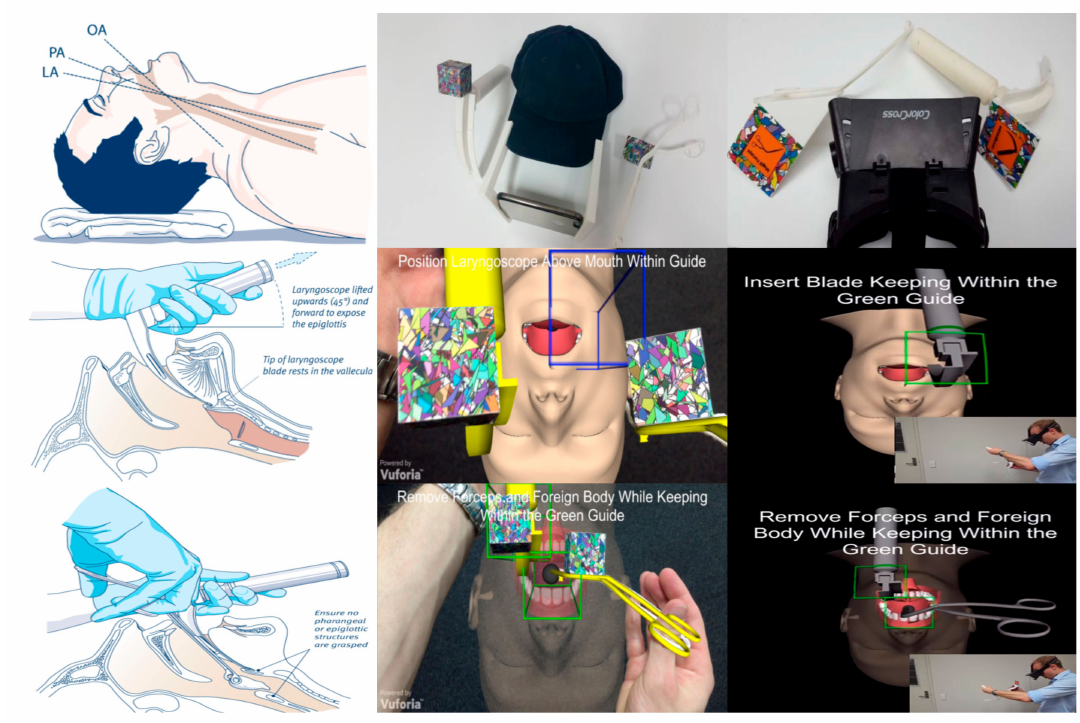
Figure 4. Steps to perform laryngoscopy for foreign body removal shown are traditional two-dimensional (2D) images, showing oral ( OA ), pharyngeal ( PA ) and laryngeal ( LA ) axes used for alignment of scope and the mixed reality visualization using three-dimensional (3D) printed objects and a AR [19] and VR [18] mobile